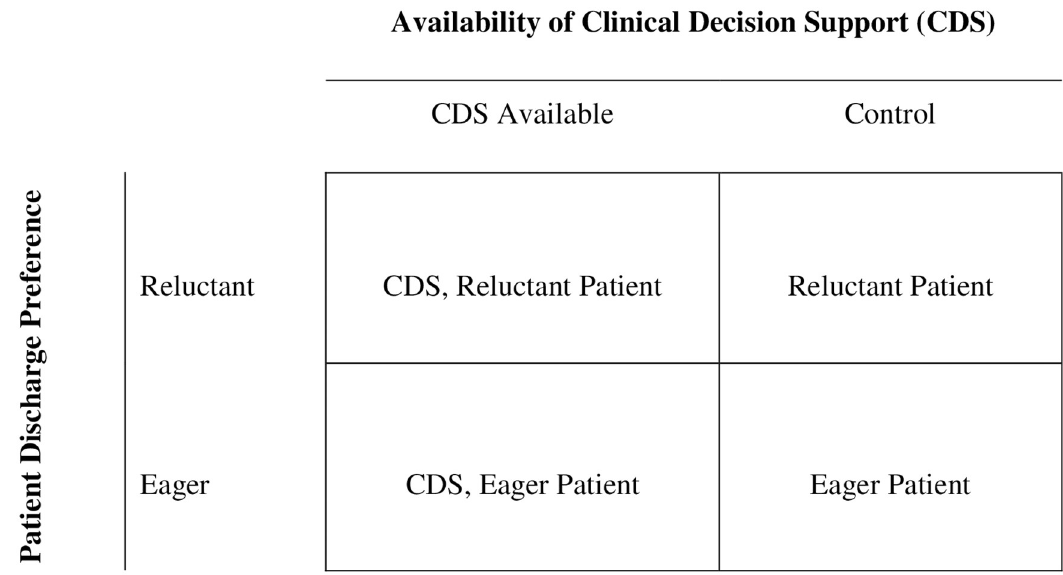
Fig 1. 2 × 2 Behavioral experimental design. Note. Four groups of participants randomly assigned to whether they had the availability of a decision support tool and for each encounter with a patient eager or reluctant for discharge.